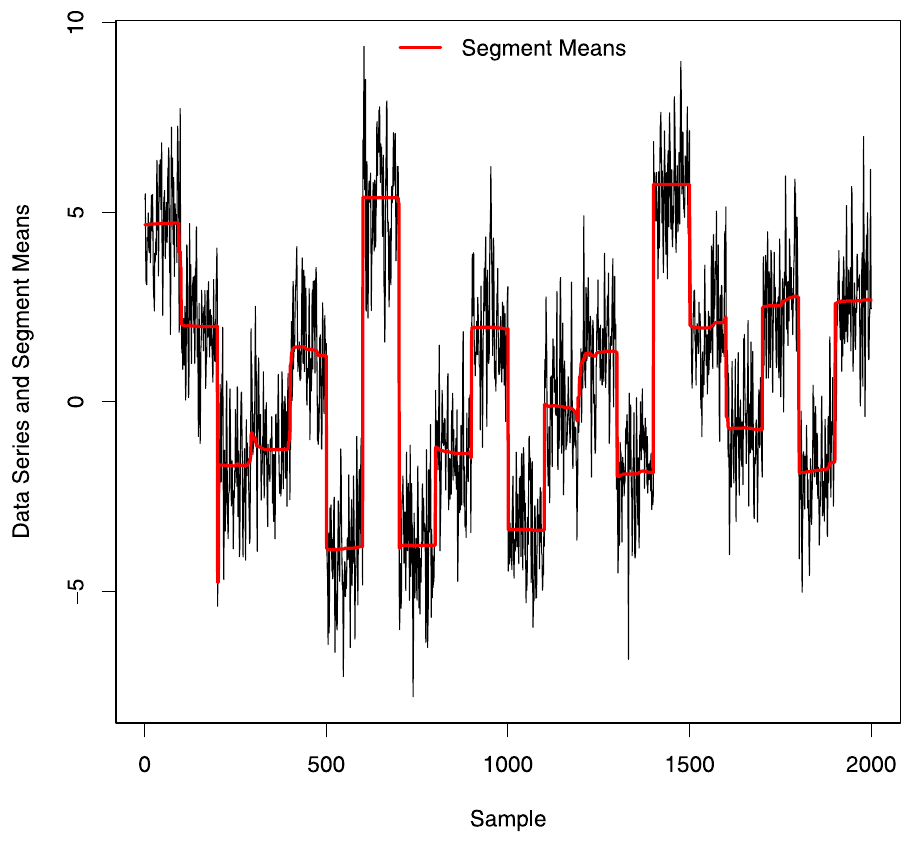
Fig 7. Segment means at each position of simulated